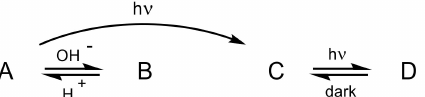
Figure 7. 1 H-NMR spectra in DMSO for [RuT0B0(NO)](PF 6 ) 3 with relative intensities: ( a ) starting compound (form A); ( b ) after 1.5 h of irradiation; ( c ) after 5 h of irradiation; ( d ) after keeping the resulting sample 3 h in the dark; ( e ) after an additional 13 h of irradiation. H-6 is selected as being the most sensitive to the nature of the X ligand present in [Ru(tpy)(bpy)(X)] n + entities.